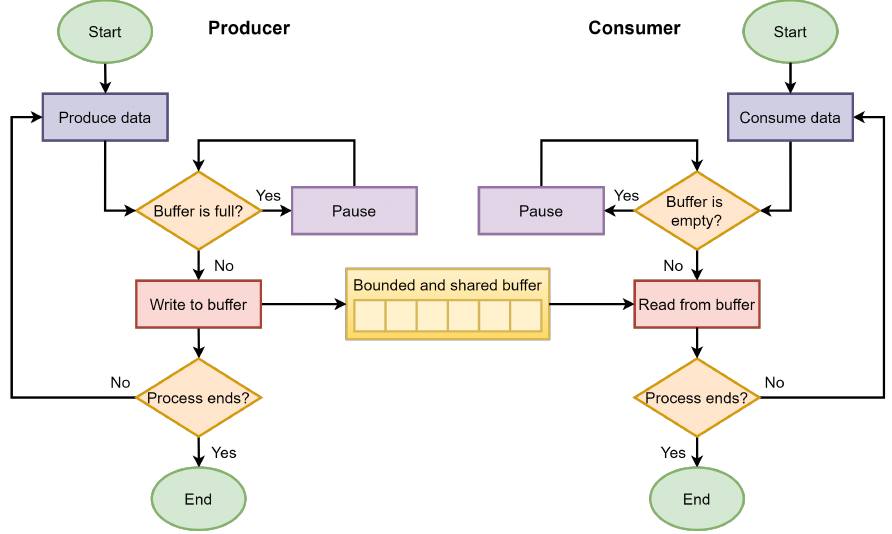
Figure 5. Flowchart of the producer–consumer